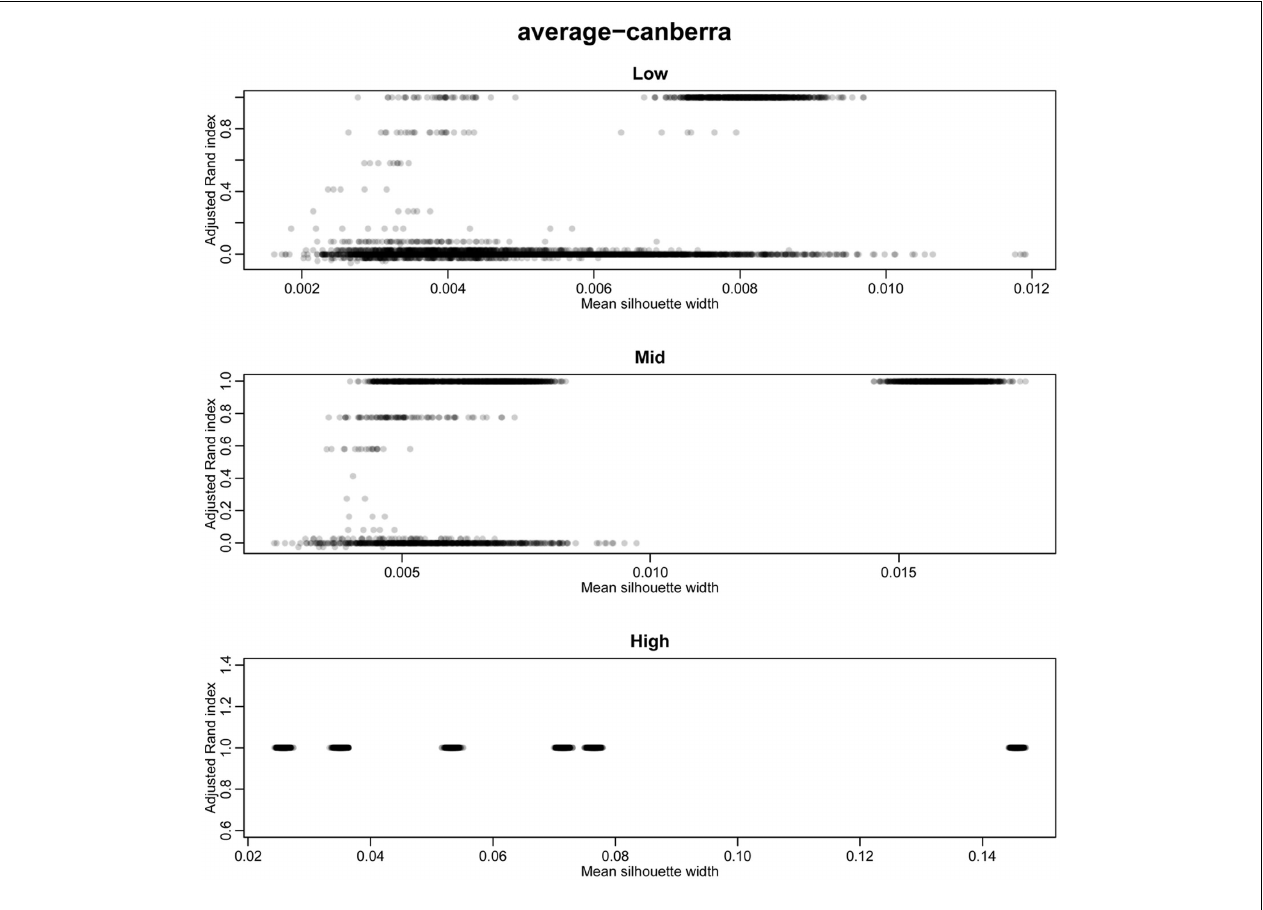
FIGUREA2 | Scatter plots of rand index versus mean silhouette width across all simulations. A gray scale of dots is used to show the density of